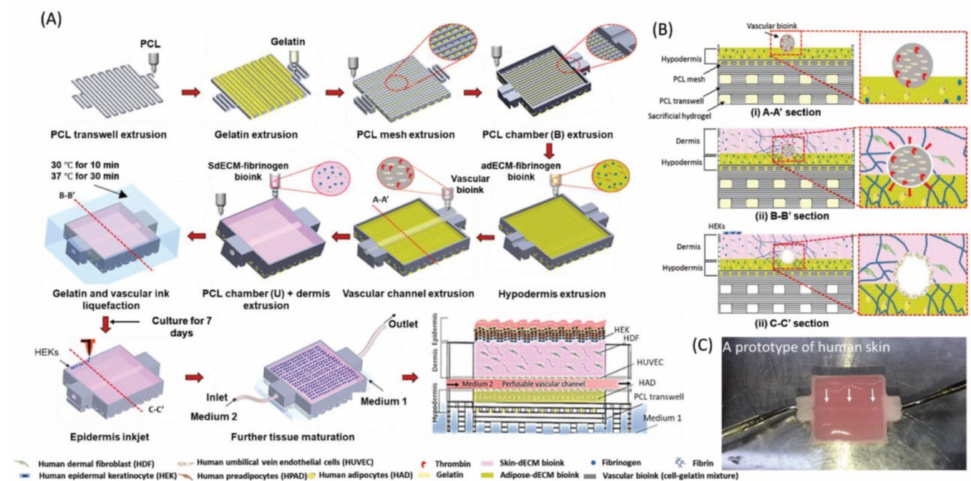
Figure 17. The 3D cell printing process for fabrication of 3D P/V full-thickness skin model. ( A ) Schematic diagram exhibiting the step-by-step fabrication process. ( B ) Sectional views provided from the aforementioned fabrication process. ( C ) A prototype of the fabricated skin construct. Reproduced from [249] with permission from John Wiley and Sons, 2018.